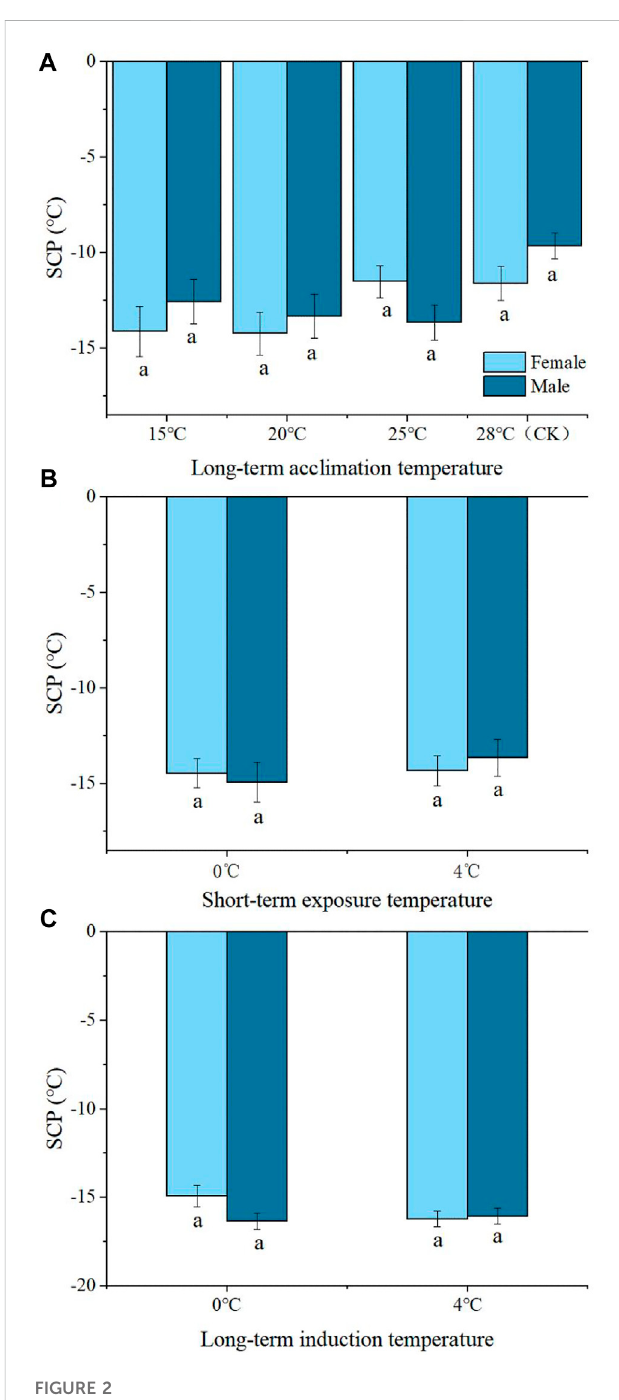
FIGURE 2 The difference of SCP of Megabruchidius dorsalis adults under different treatments (A) , long-term acclimation temperature; (B) , short- term exposure temperature; (C) , long-term induction temperature). At the same temperature, the same lowercase letters indicate no signi fi cant difference between males and females, the difference between male and female were tested by independent-samples t -test ( p <